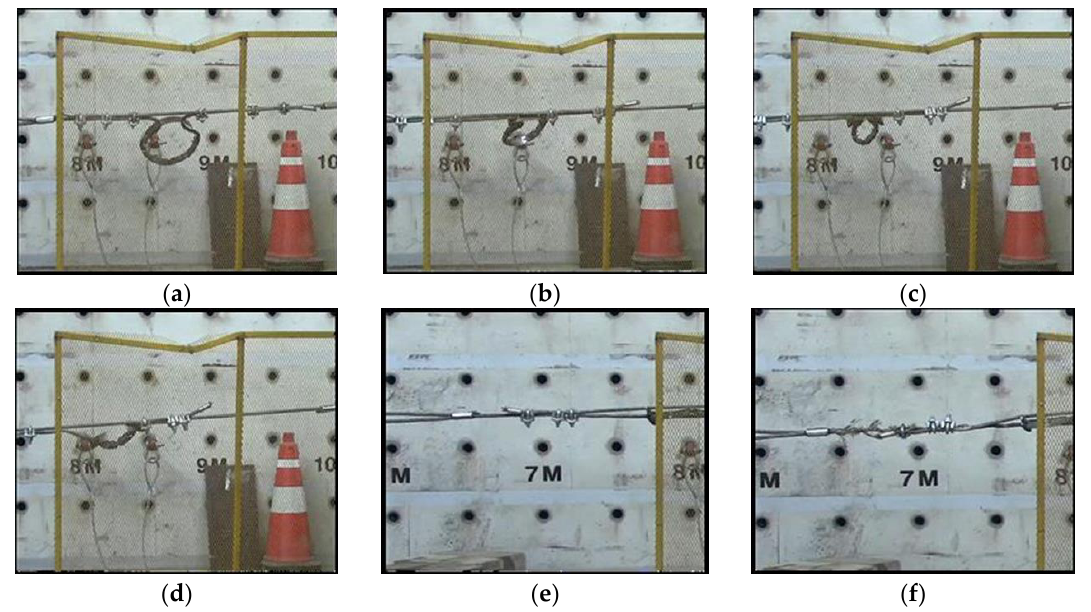
Figure 5. Illustration of deformation phases of the brake frame, ( a ) phase 1; ( b ) phase 2; ( c ) phase 3; ( d ) phase 4; ( e ) phase 5; and ( f ) phase 6.